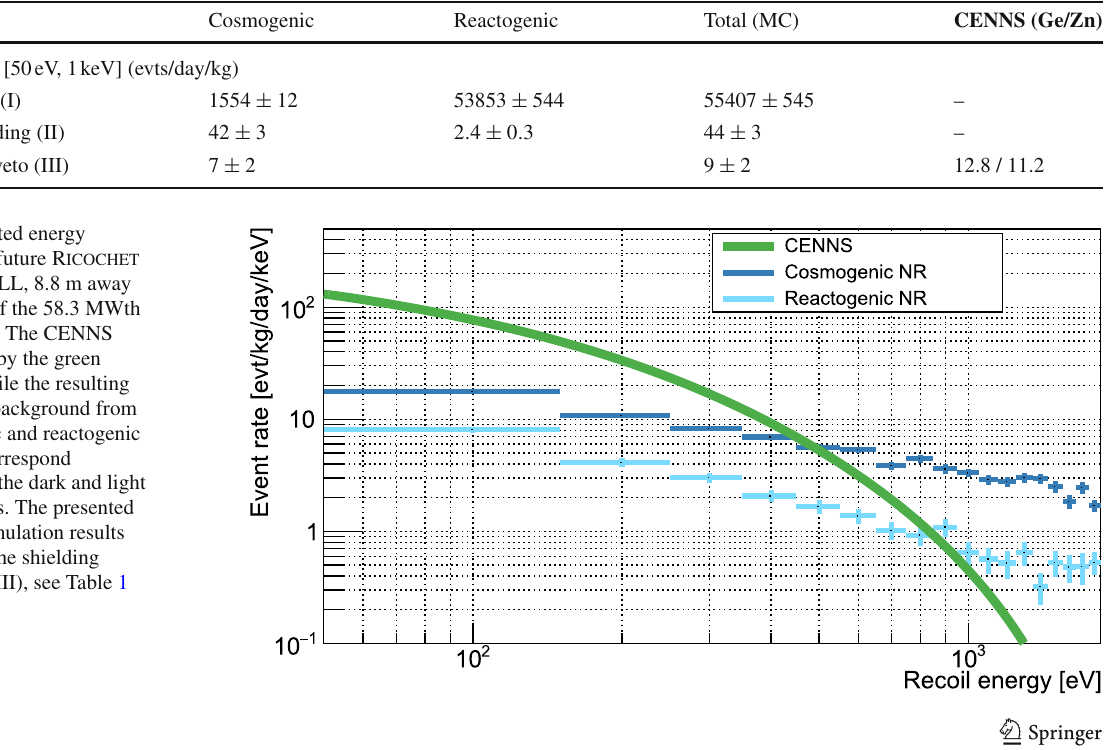
acterized and optimized, in the case of scenario (III) we assume perfect geometrical and detection efficiencies